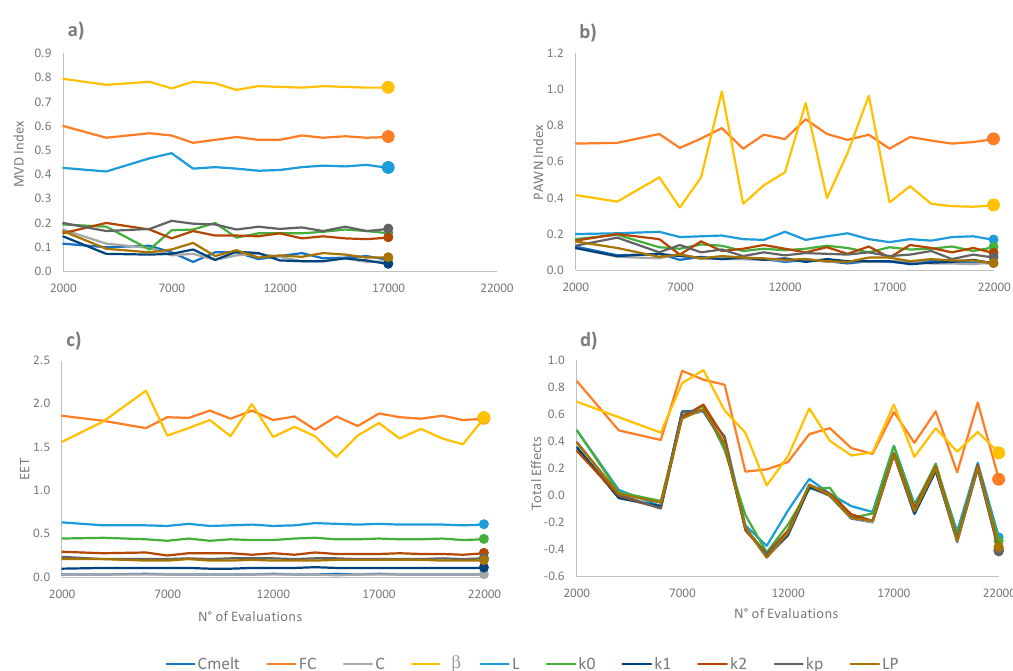
Figure 4. Convergence analysis performed for the ( a ) Regional Sensitivity Analysis (RSA), ( b ) PAWN, ( c ) Morris, and ( d ) Sobol methods. Lines indicate the sensitivity index related to each model parameter as a function of number of evaluations.